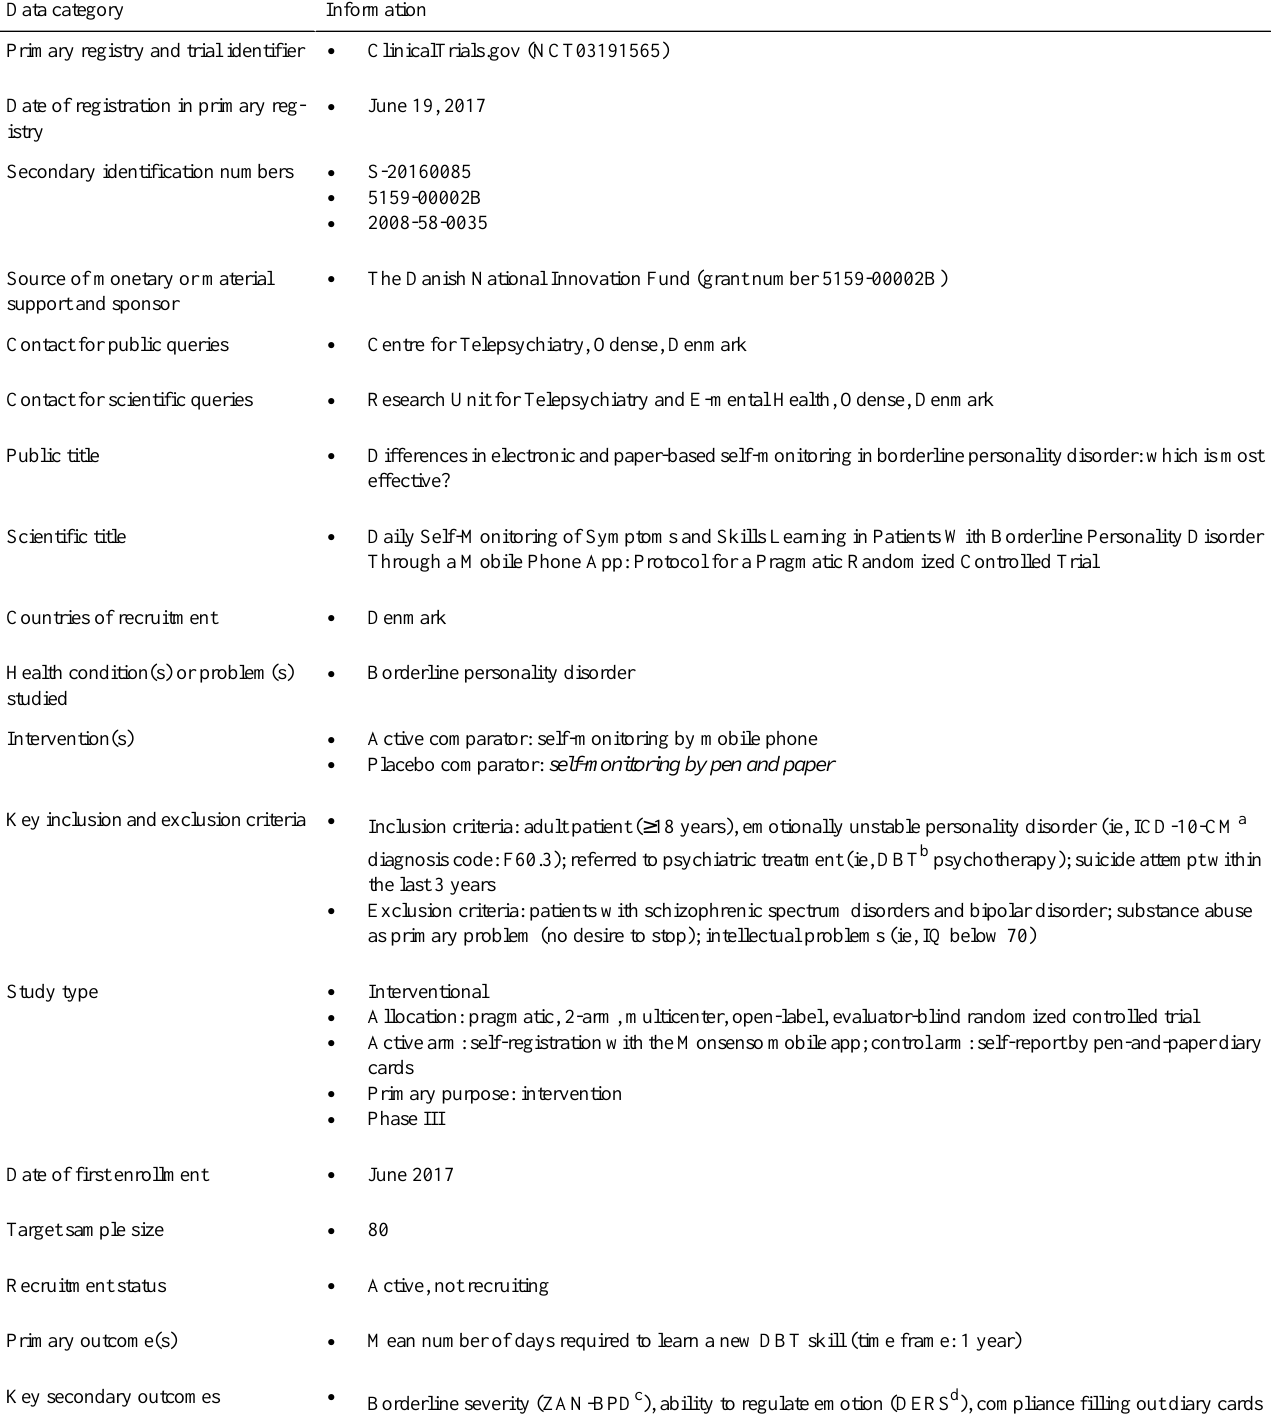
Table 1. Items from the trial registration data